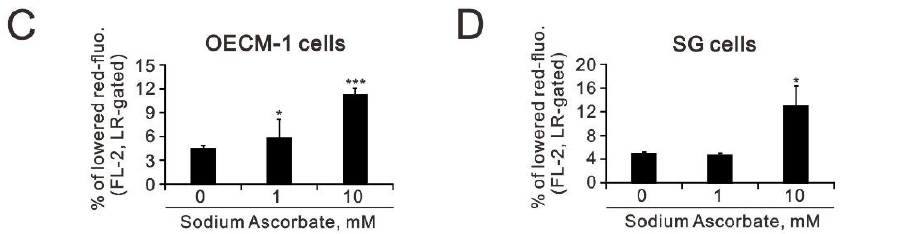
Figure 8. Effects of sodium ascorbate on the mitochondrial-membrane potential in OECM-1 and SG cells. ( A , C ) OECM-1 (3.5 × 10 5 ) and ( B , D ) SG (3.5 × 10 5 ) cells were cultured in 6-well plates and treated with the indicated concentrations of sodium ascorbate for 4 h, after which the live cells were stained with 5 µ M JC-1 dye. ( C , D ) Bars depict the mean ± SD of three independent experiments. Student’s t -tests were analyzed and compared with vehicle. * p < 0.05 and *** p < 0.001.